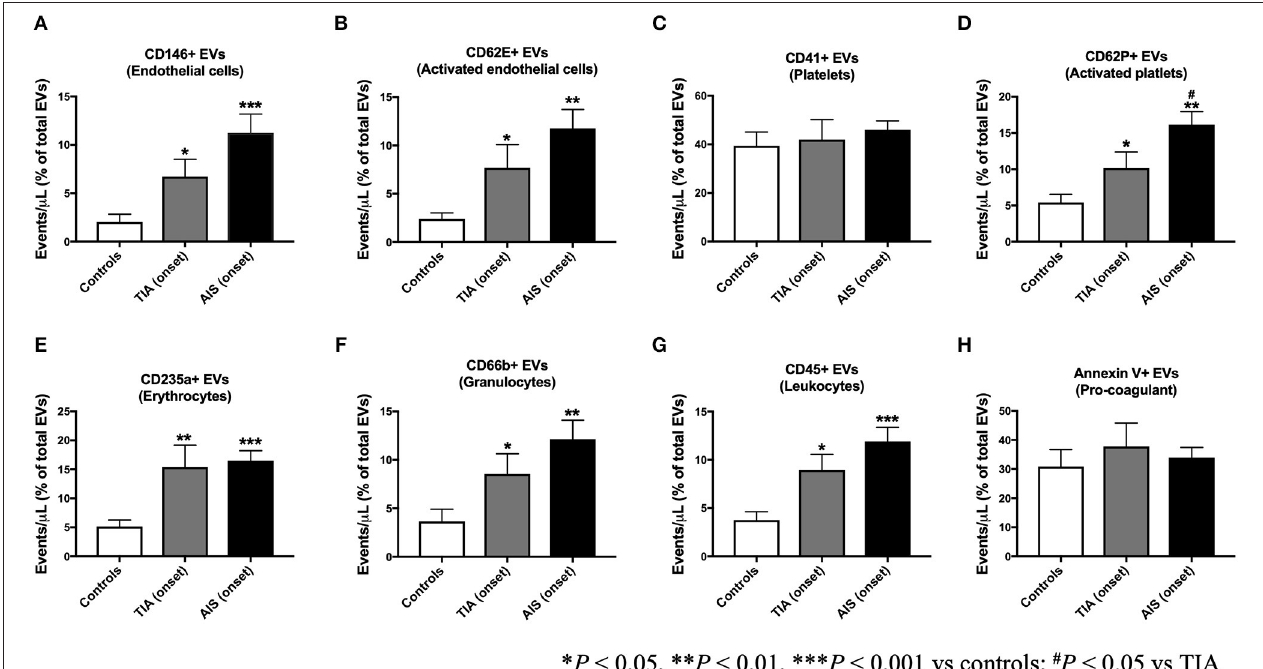
FIGURE 2 | Circulating EV levels, expressed as percentage of total EVs, at onset of attacks, in patients with TIA and AIS compared to healthy controls. Histograms represent circulating levels of EVs derived from: (A) endothelial cells (CD146 + ), (B) activated endothelial cells (CD62E + ), (C) platelets (CD41), (D) activated platelets (CD62P + ), (E) erythrocytes (CD235a + ), (F) granulocytes (CD66b + ), (G) leukocytes (CD45 + ), (H) and pro-coagulant (Annexin V + ) origins. Histograms represent events/ µ L (% of total EVs) in PFP expressed as mean ± SEM. Controls, n = 24; TIA, n = 21; AIS, n = 66. * P < 0.05, ** P < 0.01, *** P < 0.001 vs. controls; # P < 0.05 vs. TIA.